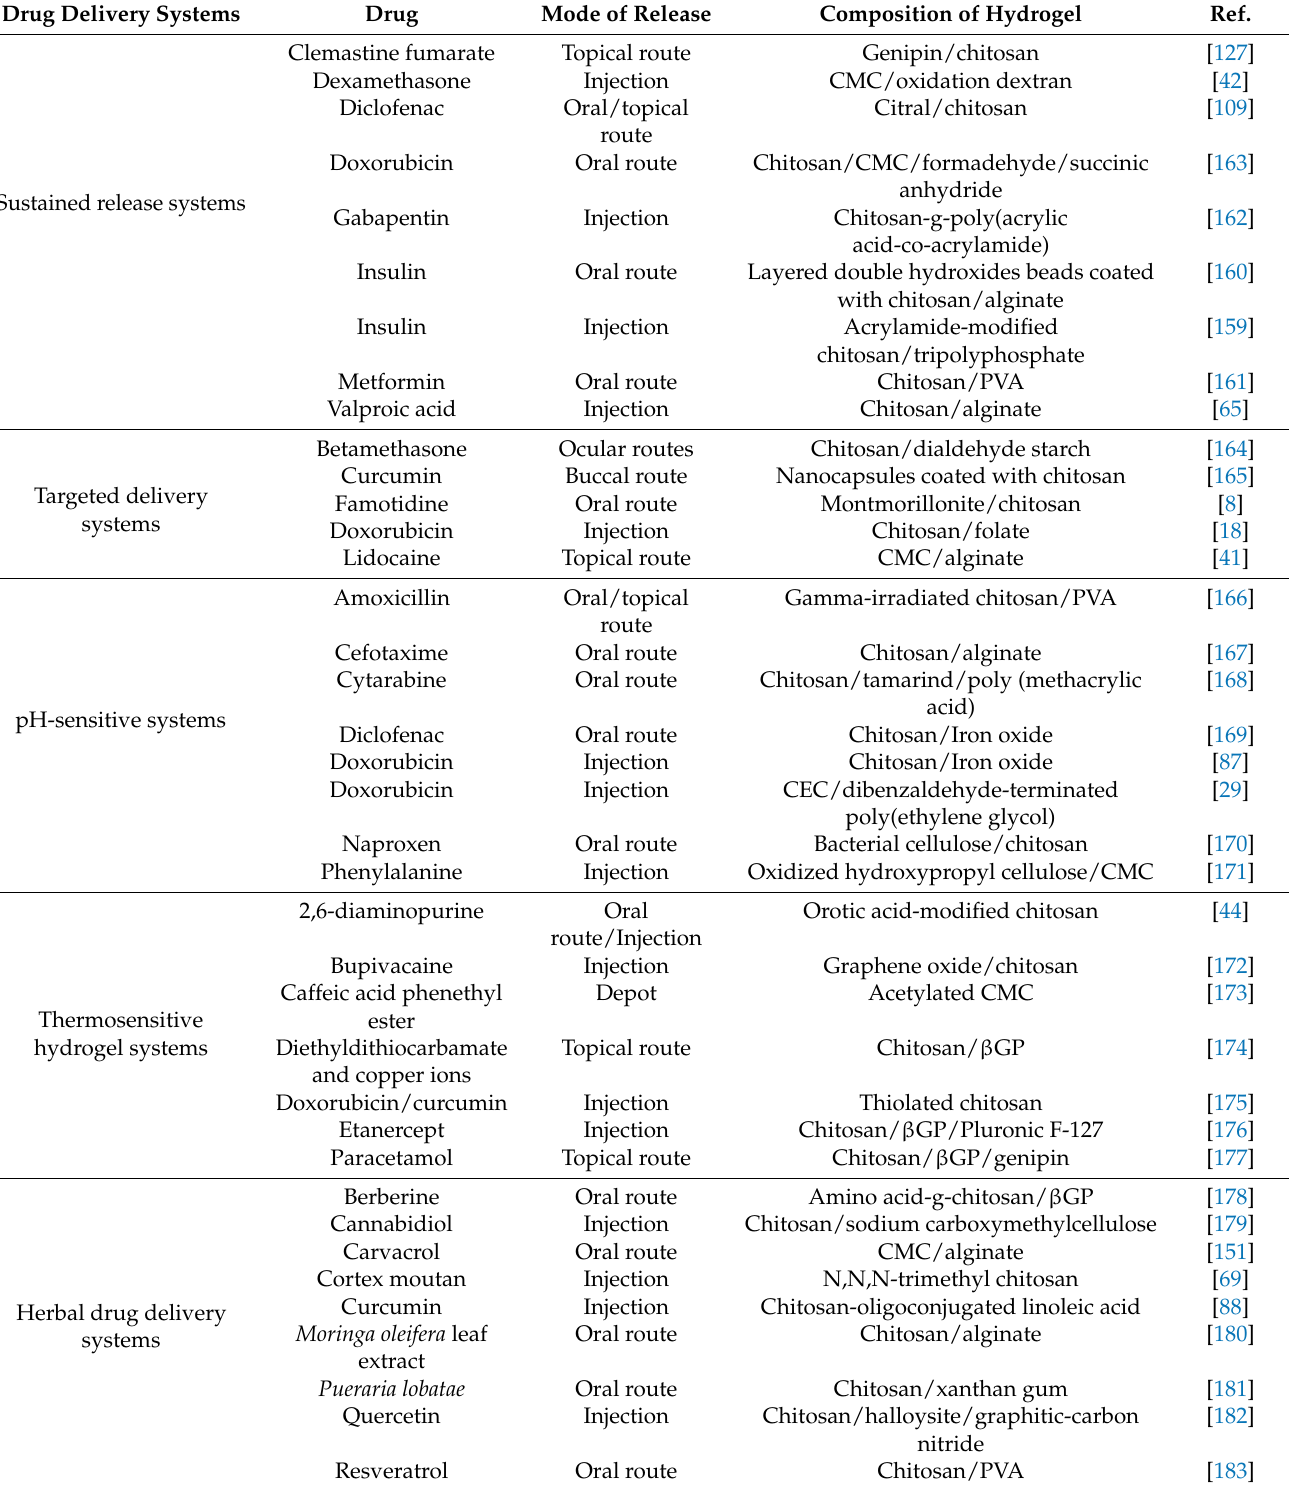
Table 2. Delivery systems and release modes of various drugs from chitosan-based